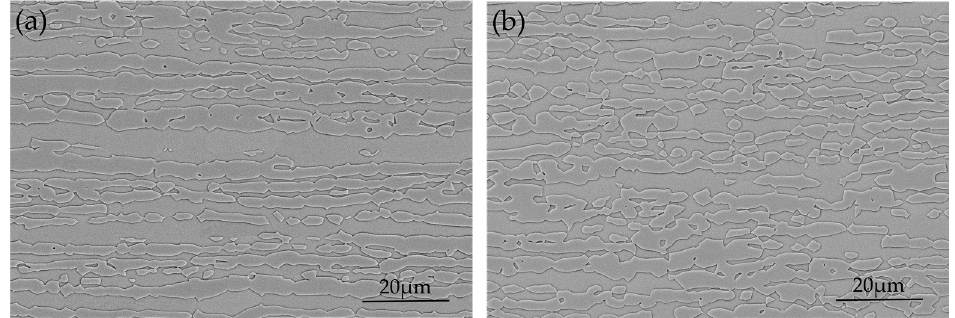
Figure 1. Cross-section microstructure of DSS 2304 as received showing austenitic islands in the ferritic matrix: ( a ) parallel to rolling direction; and ( b ) perpendicular to rolling direction. Table 2. Macroscopic mechanical properties of DSS 2304 measured perpendicular to the rolling direction at room temperature.